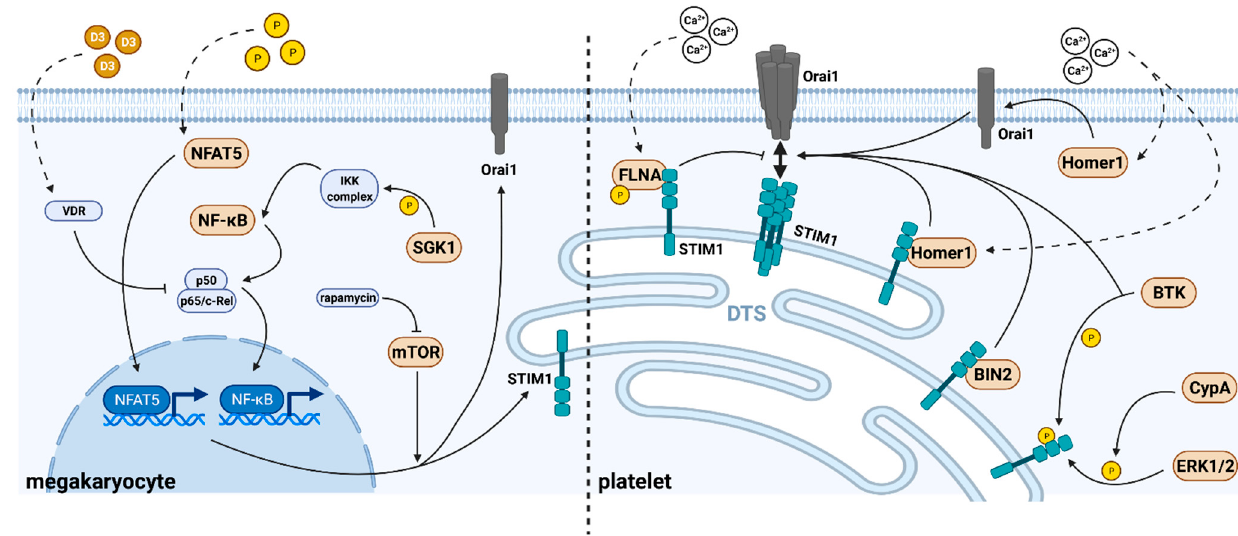
Figure 2. Molecular regulation of the SOCE in megakaryocytes and platelets. Left: In megakaryocytes, the expression levels of STIM1 and Orai1 are regulated by transcriptional processes. Extracellular phosphate (P) activates NFAT5-dependent transcription, while SGK1 and 1,25(OH) 2 D3 (D3) affect the NF- κ B-dependent transcription via the I κ B kinase (IKK) complex or the vitamin D receptor (VDR), respectively. Since mTOR affects translation processes, both transcriptional and translational regulation in megakaryocytes determine the final protein levels of STIM1 and Orai1 in platelets. Right: In platelets, the SOCE is mainly affected by direct protein-protein interactions or posttranslational modifications of STIM1 and Orai1 which subsequently regulate the interaction of the subunits and finally the formation of the CRAC.